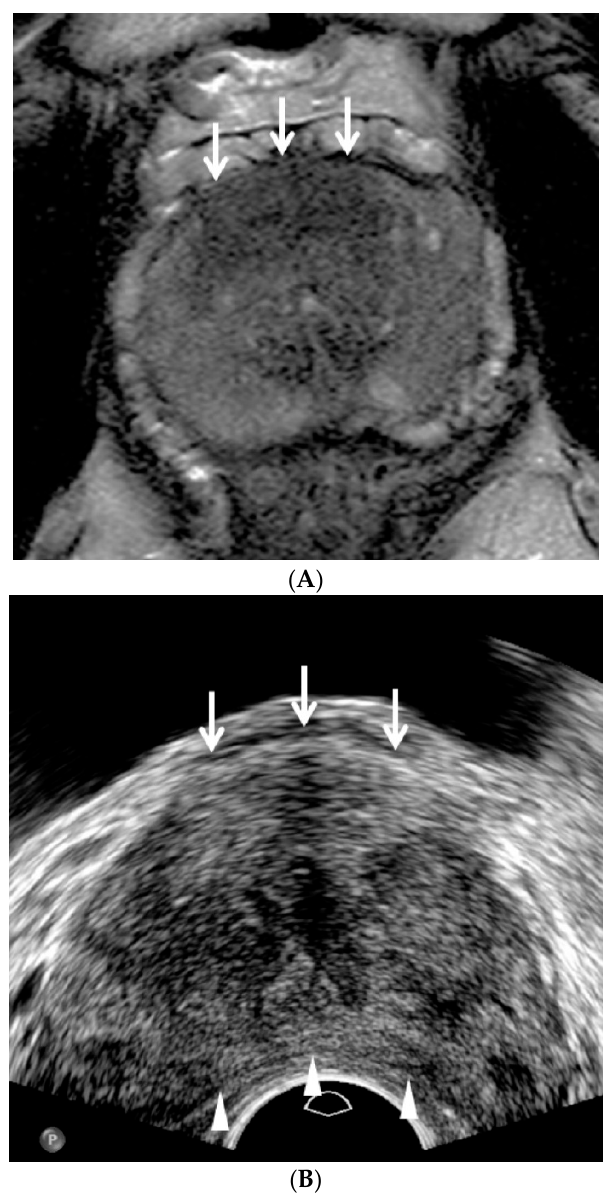
Figure 3. A PI-RADS 5 transition cancer in a 61-year-old man. ( A ) T2-weighted axial MR image shows a moderately hypointense transition lesion (white arrows) in the anterior midline base measuring 2.7 cm, suggesting that the PI-RADS lesion category is 5. The patient’s PSA level was 12.27 ng/mL prior to biopsy. ( B ) TRUS axial image clearly shows a hyperechoic transition lesion (white arrows) in the anterior midline mid-gland. The TRUS lesion is located more inferiorly to the MRI lesion. White